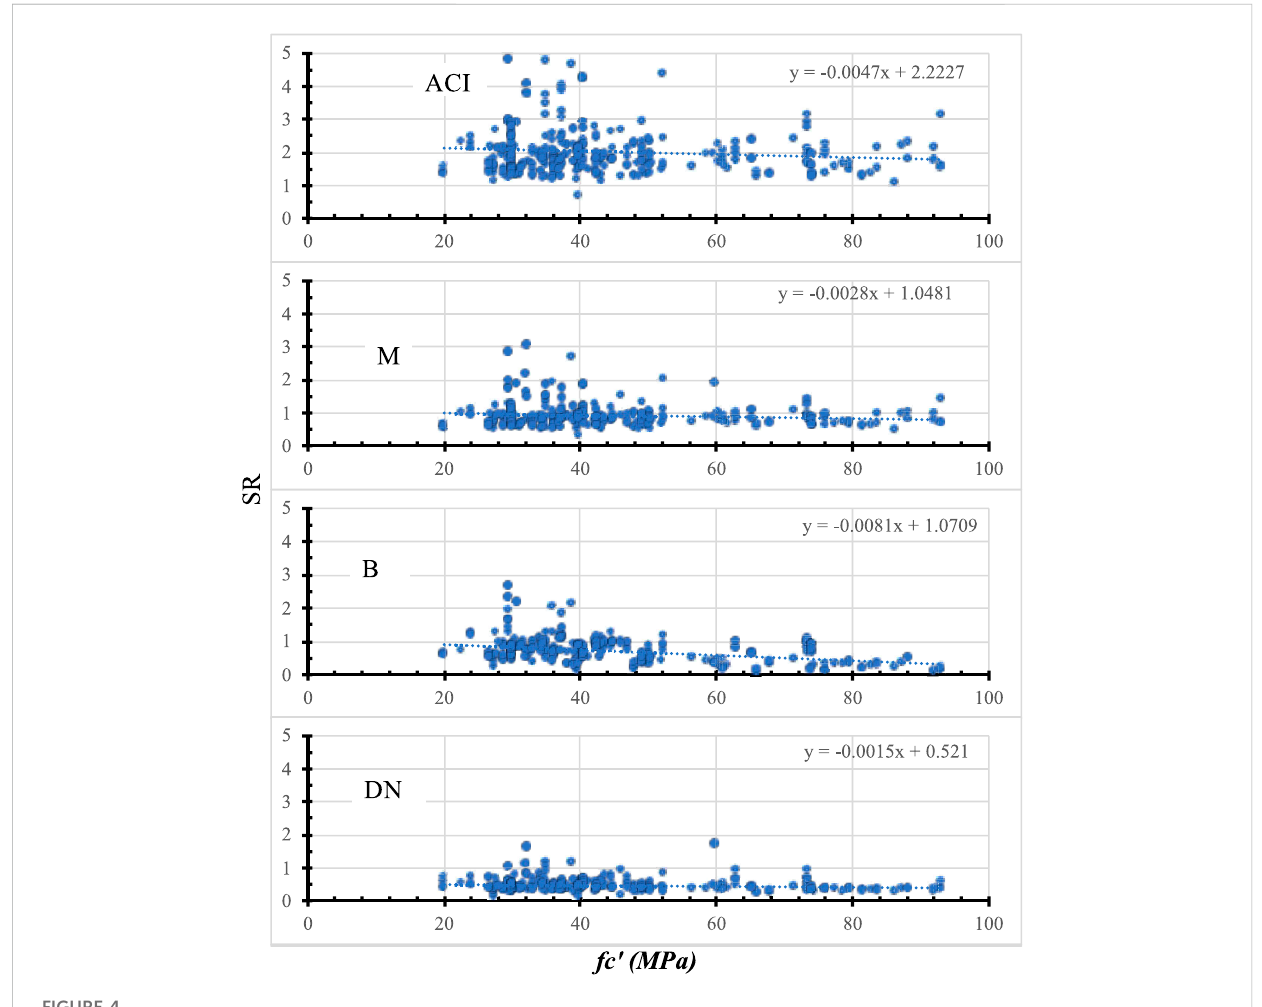
FIGURE 4 SR calculated using selected model versus concrete compressive